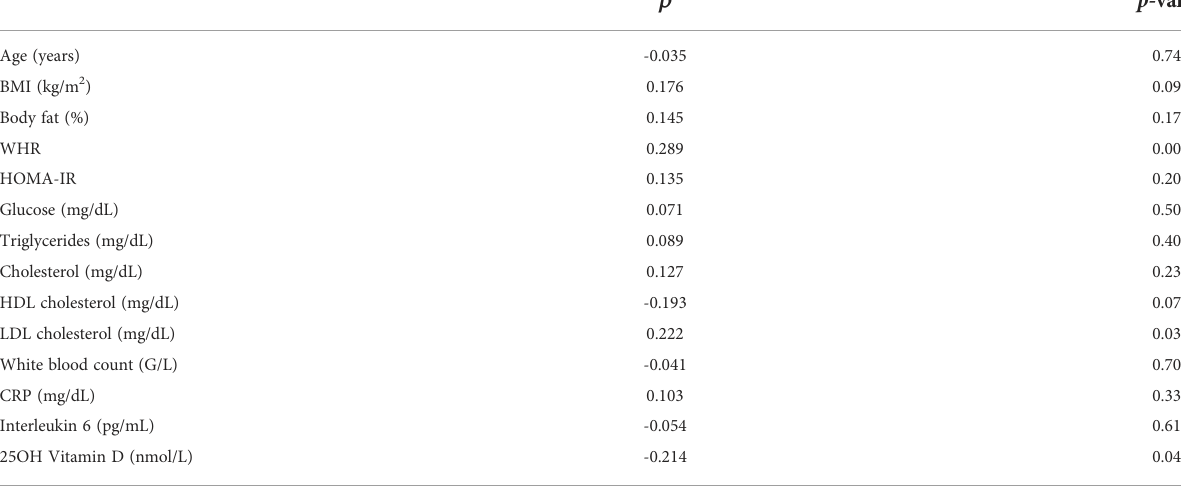
TABLE 2 Associations between TTV load and anthropomorphic, metabolic, and in fl ammatory laboratory values.